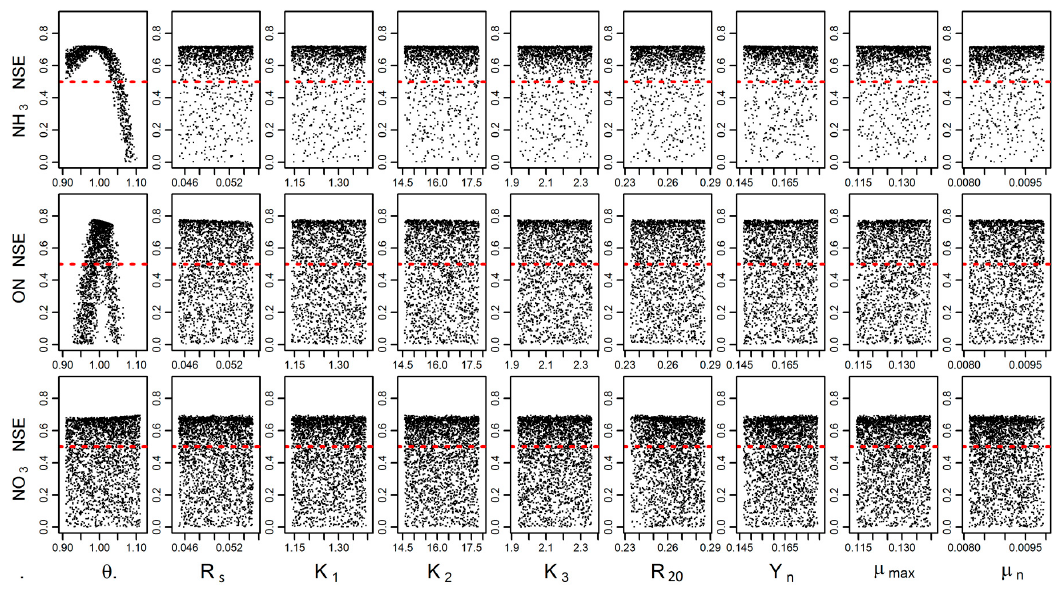
Figure 6. Scatter plot of Nash–Sutcliffe coefficient of efficiency (NSE)-sensitive parameters based on generalized likelihood uncertainty estimation (GLUE) method for ammonia nitrogen (NH3-N), organic nitrogen (ON-N), and Nitrate (NO 3 -N). Note: dots represent the Nash–Sutcliffe coefficient value for each iteration; red horizontal line indicates the NSE minimum criteria.